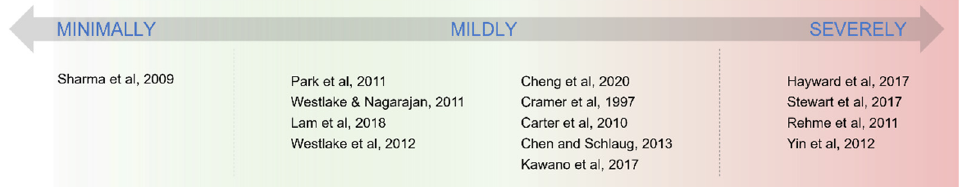
Figure 2. List of references describing patients with different functional and structural connectivity reorganization depending on the level of impairment. Mildly affected patients, in the middle, can either develop in a more “minimally affected” fashion or, on the contrary, can develop towards patterns more similar to severely affected patients.